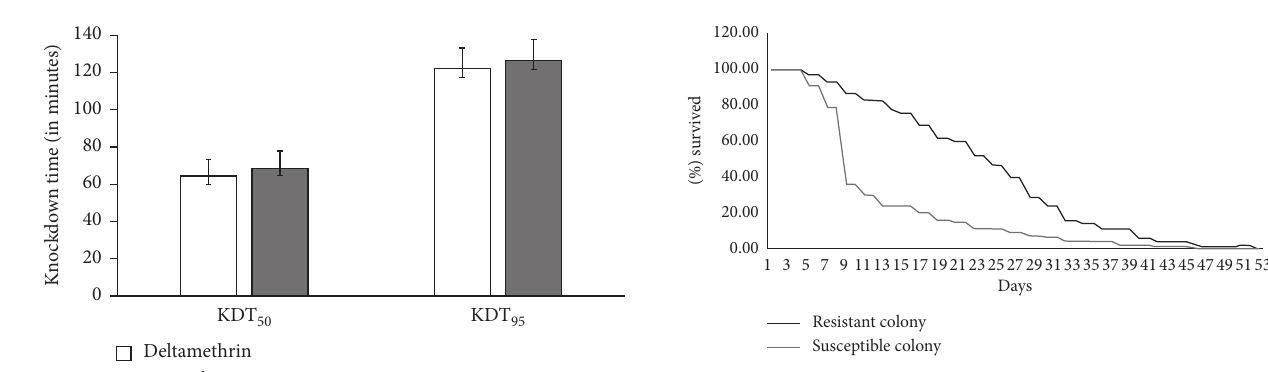
Figure 4: The proportion of resistance ( An. gambiae s.l . ) and susceptible ( An. gambiae s.s . ) survived after blood meal. Figure 2: The mean KDT 50 and KDT 95 for deltamethrin and permethrin against Anopheles gambiae s.l .